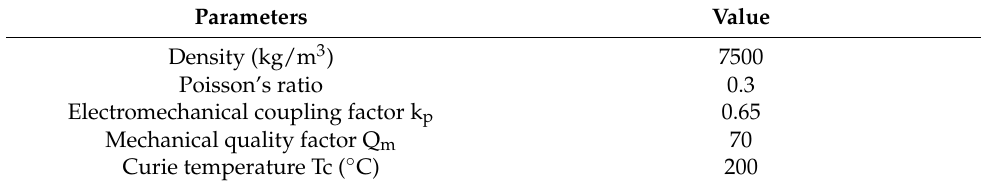
Figure 5. Validation of the piezoelectric unit simulation.